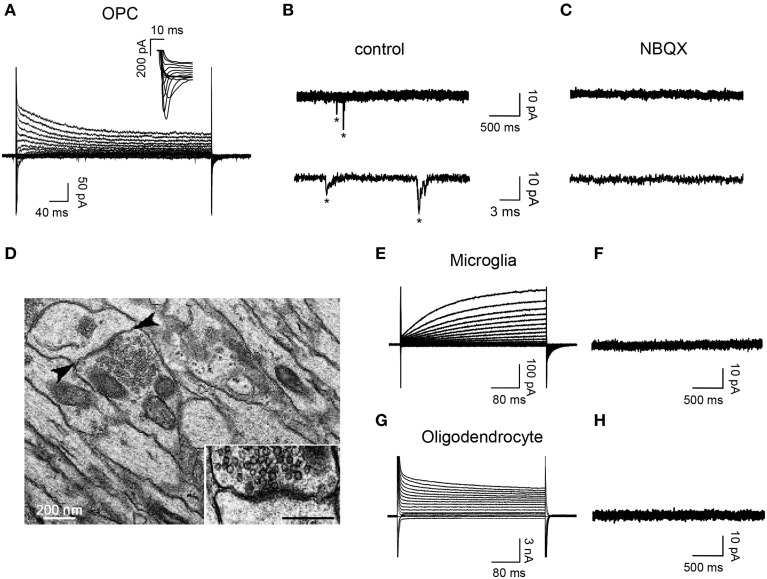
OPCs display NBQX-sensitive spontaneous synaptic activity while microglia and oligodendrocytes completely lack synaptic events. (A) Currents elicited in an OPC at 7 dpi by voltage steps from +40 to −120 mV. Note the presence of INa+ (inset). (B,C) Spontaneous synaptic currents (*) recorded at −90 mV from the same OPC in control (B, frequency: 1.34 Hz) and after bath applying 10 μM NBQX (C, frequency: 0 Hz). (D) Electron-micrograph of a LPC lesion at 14 dpi, illustrating a typical synaptic contact between an axon and a putative OPC process (arrowheads, inset). Note that the postsynaptic process lacks gliofilaments and lipofuscin granules, two typical features of astrocytes and microglia, respectively. (E,G) Currents induced by voltage steps from +40 to −120 mV in a microglia at 7 dpi (E) and an oligodendrocyte at 14 dpi (G) held at −90 mV. (F,H) Currents recorded at −90 mV from the same cells. Note the lack of synaptic events in both cells types (n = 12 and n = 14 for microglia and oligodendrocytes, respectively). Scale bar for inset: 200 nm.